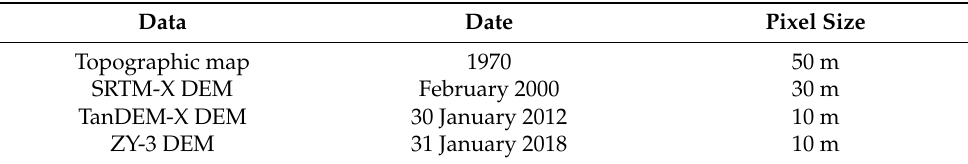
Table 1. DEM data used in this study.